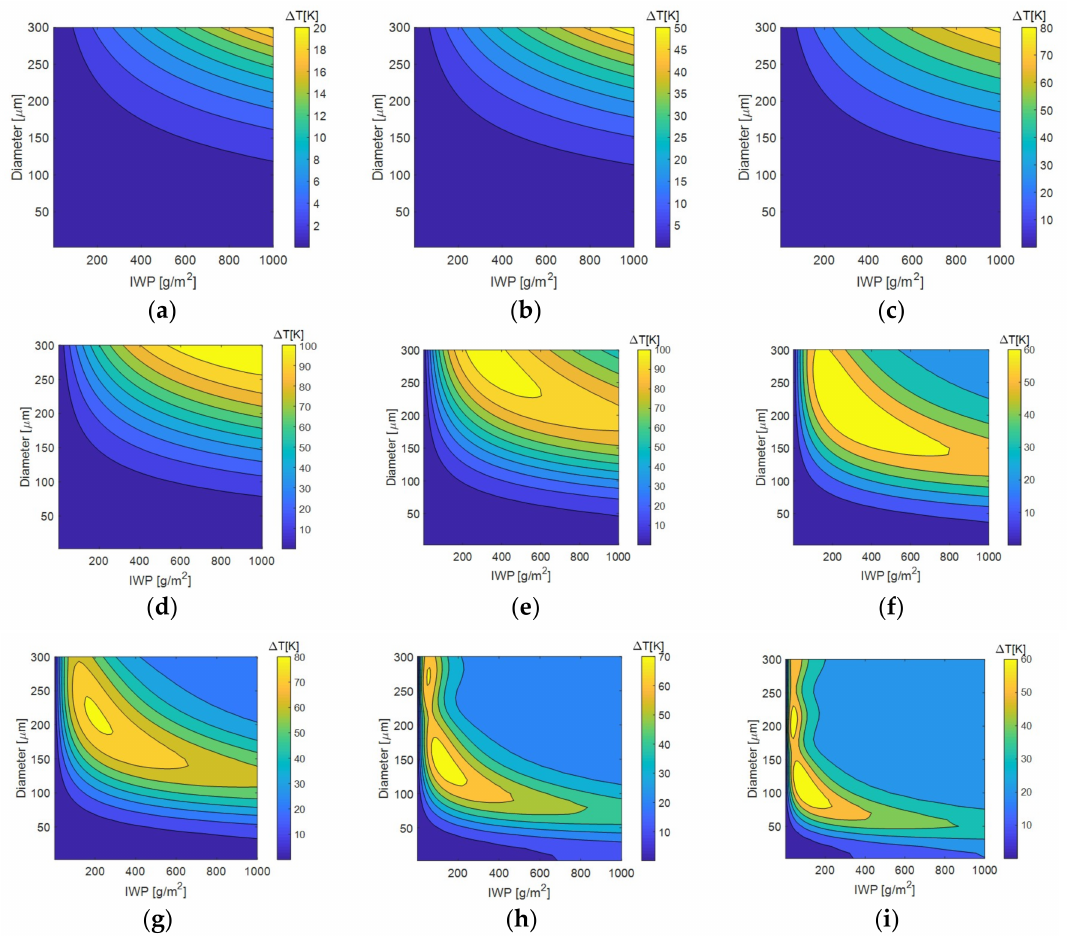
Figure 5. Brightness temperature di ff erence caused by di ff erent particle sizes and ice water paths. ( a ) 118.75 ± 5.0 GHz (O2). ( b ) 157.05 ± 2.6 GHz (Window). ( c ) 183.31 ± 7.0 GHz (H2O). ( d ) 243.20 ± 2.5 GHz (Window). ( e ) 325.15 ± 9.5 GHz (H2O). ( f ) 424.70 ± 4.0 GHz (O2). ( g ) 448.0 ± 7.2 GHz (H2O). ( h ) 664.0 ± 4.2 GHz (Window). ( i ) 874.4 ± 6.0 GHz